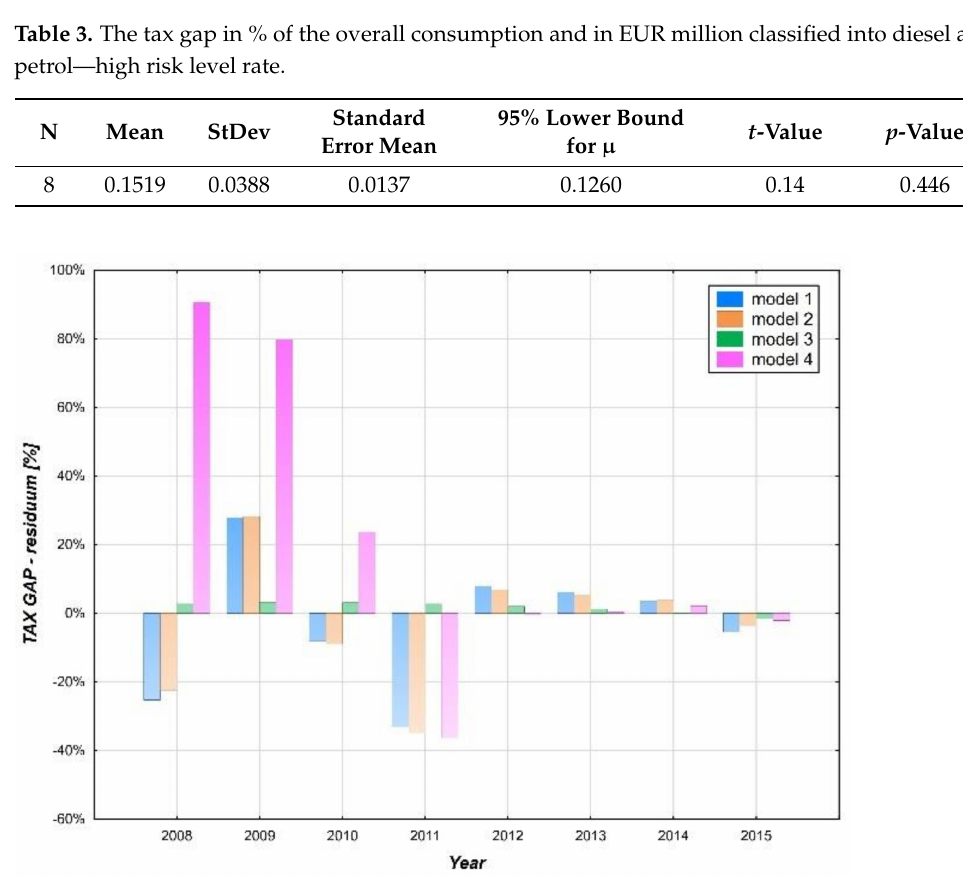
Figure 9. Residues of the prediction models of TAX GAP in the years 2008–2015. Based on the available data from 2008 to 2015, the basis for a prediction of the future development of the examined variables was created. The prediction itself was